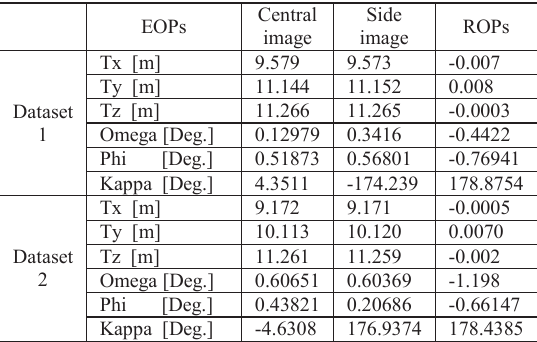
Table 3. EOPs of each lens and ROPs between them.